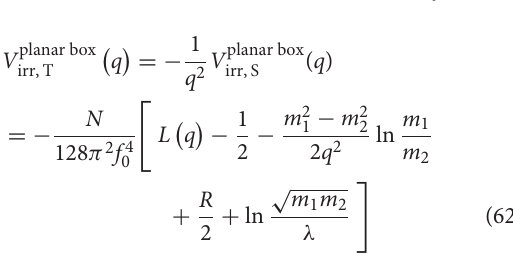
At next-to-leading order the two-meson exchange diagrams start to contribute. The planar box in Figure 7B contains an irreducible part and a reducible part coming from the iteration of